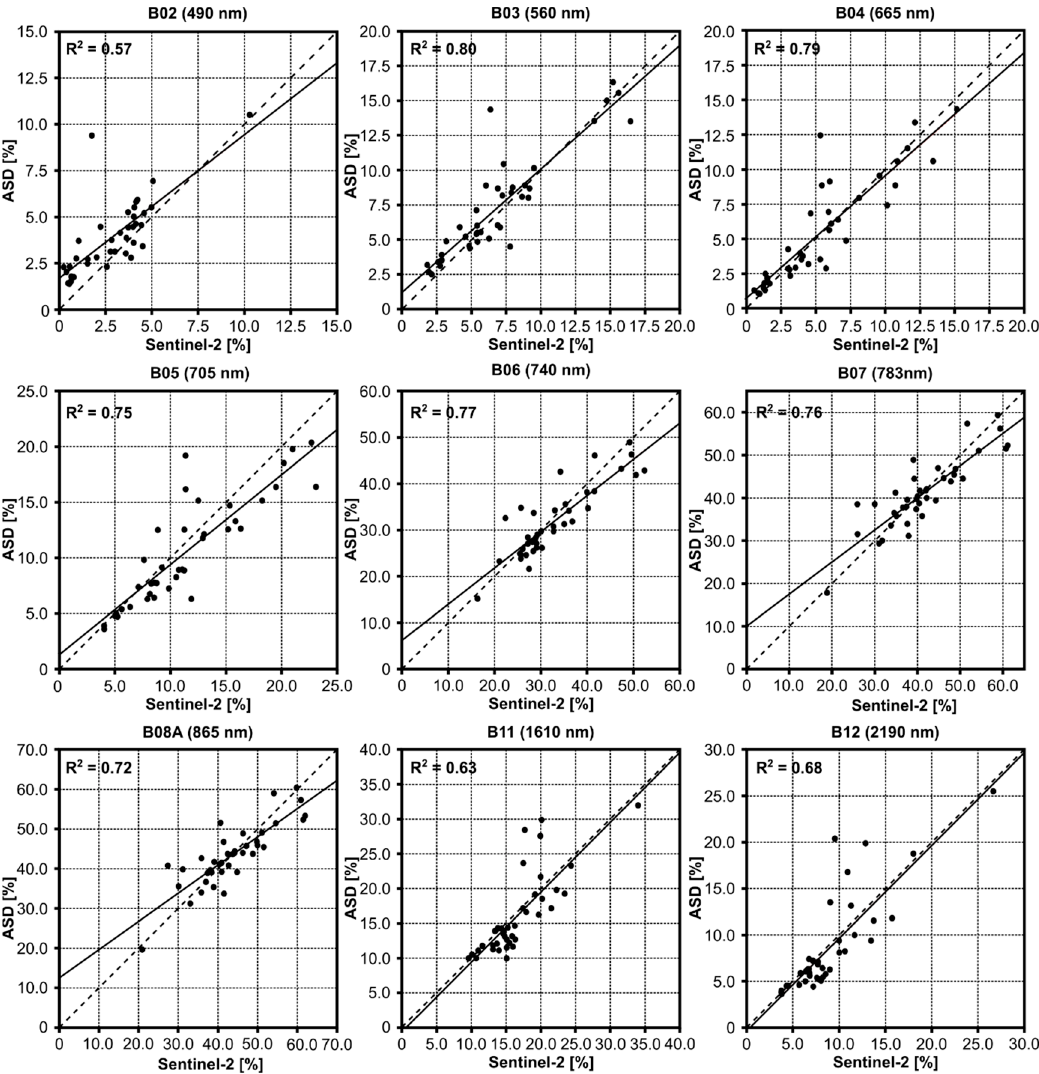
Figure 5. Scatter plots over Sentinel-2 spectral bands between Sentinel-2 observations and the canopy-level spectra measured in situ at sample points.